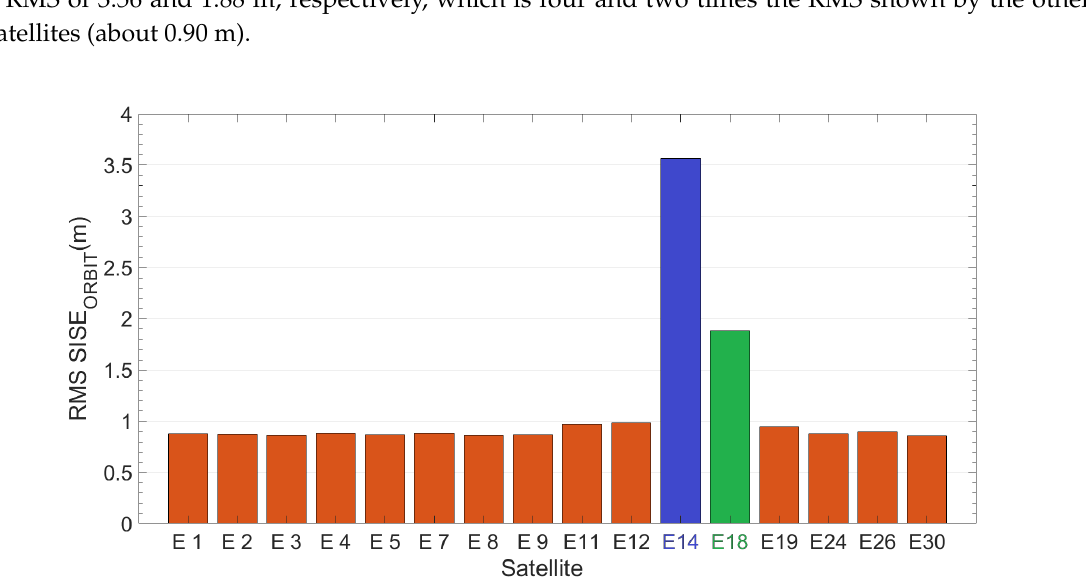
Figure 3. RMS SISE orbit calculated on the dataset ranging from DOY 52 to 71 for all Galileo satellites. Blue and green are Milena (E14) and Doresa (E18) satellites, respectively. Ephemeris validity time threshold is set to 14,400